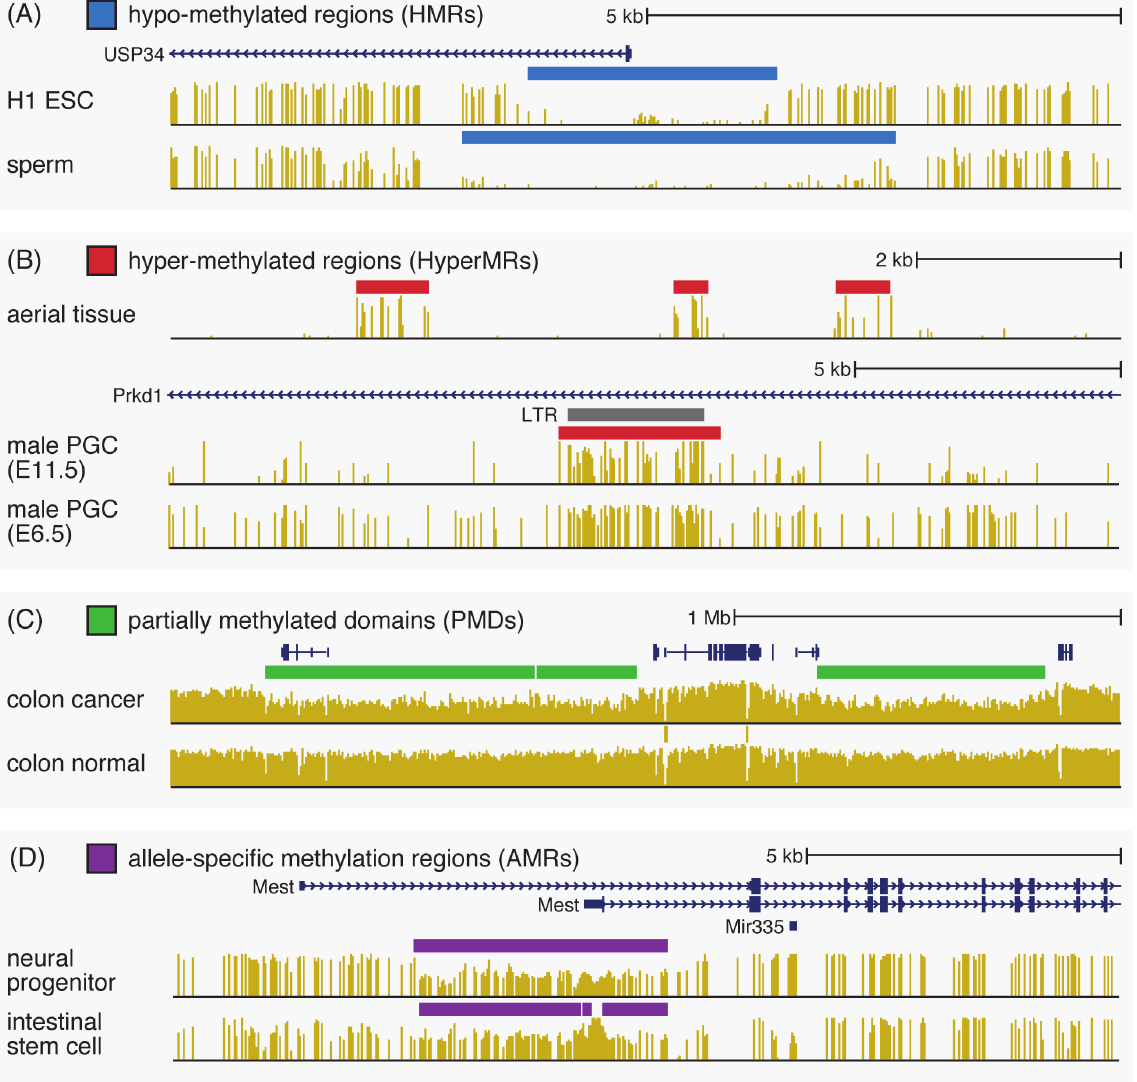
Figure 1. Examples of high-level methylation features available in MethBase through the UCSC Genome Browser track hub. (A) hypo-methylated regions (HMRs); (B) hyper-methylated regions (HyperMRs); (C) partially methylated domains (PMDs), and (D) allele-specific methylated regions (AMRs).